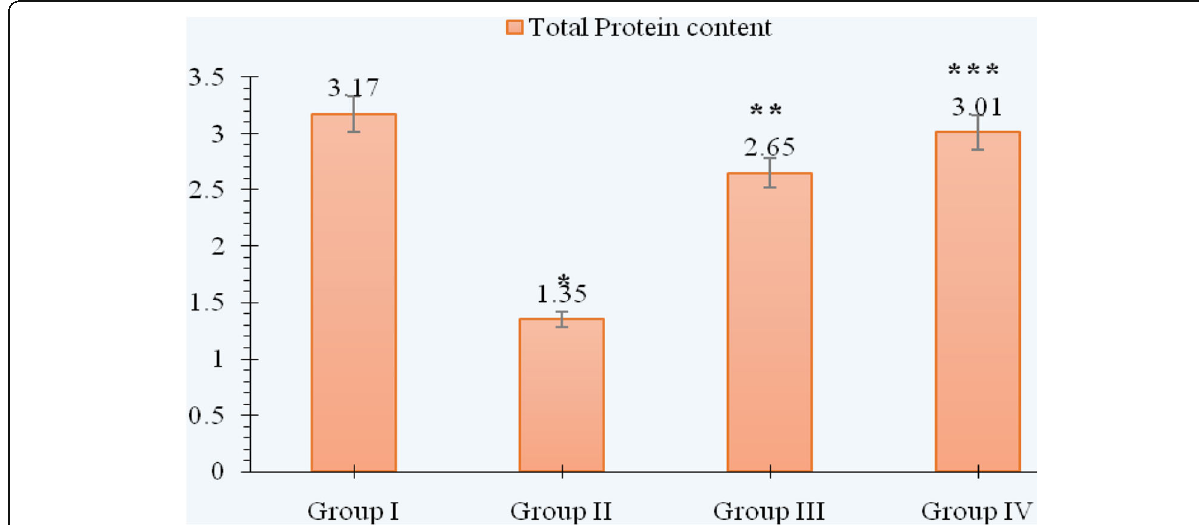
Fig. 7 Total Protein content of various groups. * p < 0.001 as compared to group I, ** p < 0.01 as compared to group II and *** p < 0.001 as compared to group